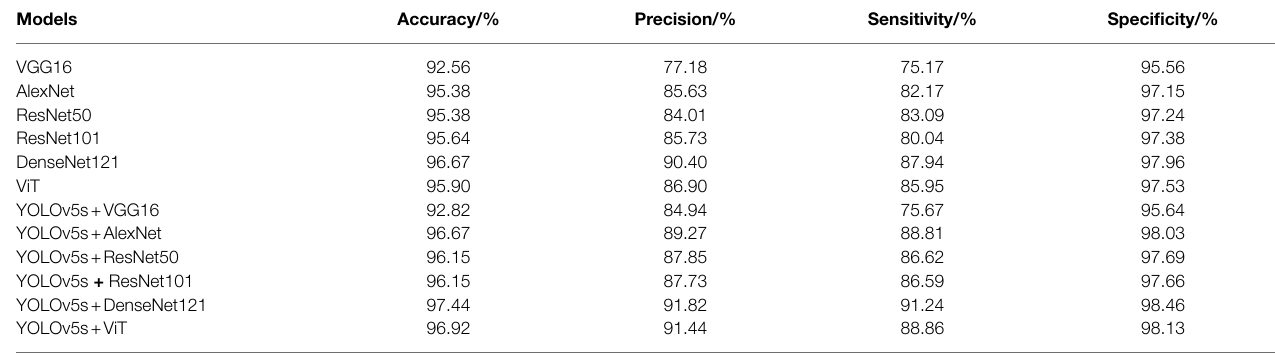
TABLE 5 | Comparison of image classification